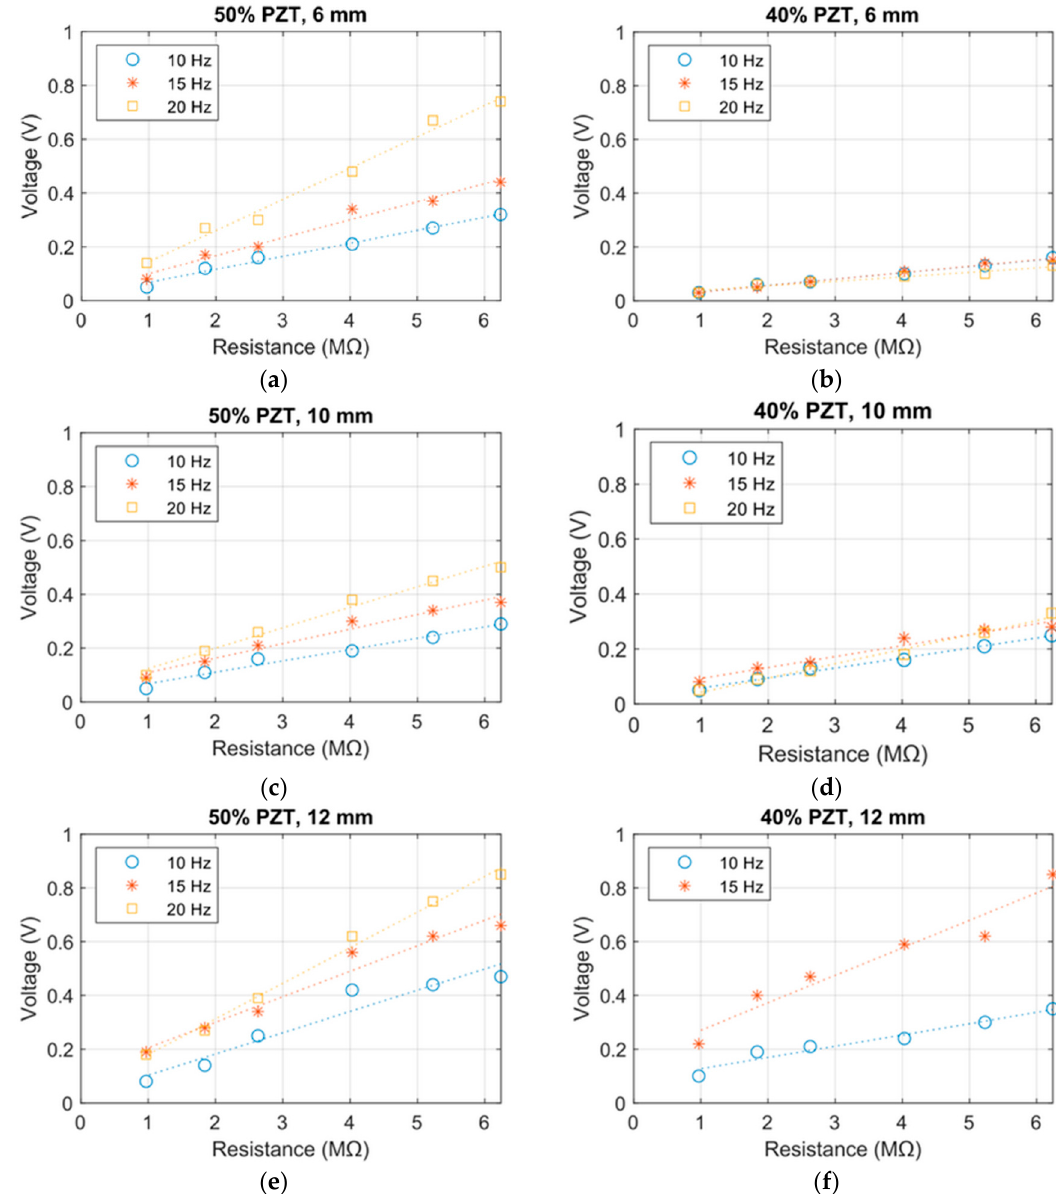
Figure 9. Courses of voltage generated by the manufactured beam: ( a ) initial volume share of PZT: 50% and vibration amplitude: 6 mm; ( b ) initial volume share of PZT: 40% and vibration amplitude: 6 mm; ( c ) initial volume share of PZT: 50% and vibration amplitude: 10 mm; ( d ) initial volume share of PZT: 40% and vibration amplitude: 10 mm; ( e ) initial volume share of PZT: 50% and vibration amplitude: 12 mm; ( f ) initial volume share of PZT: 40% and vibration amplitude: 12 mm (missing the 20 Hz measurements plot, as the specimen broke during the experiment).